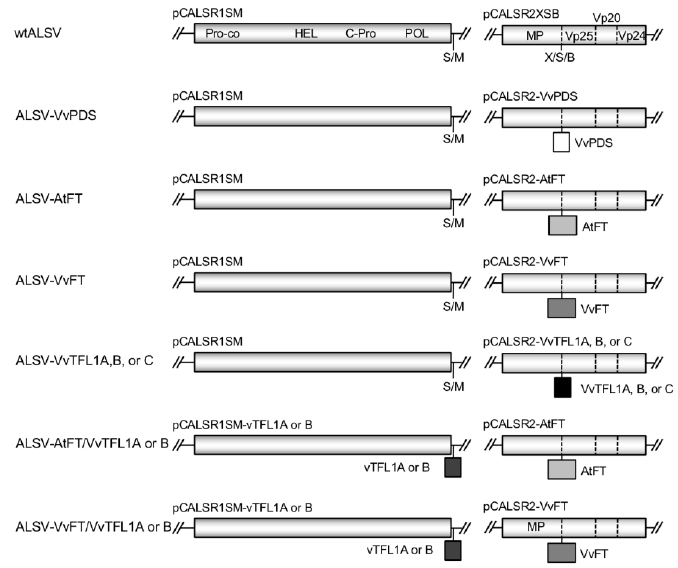
Figure 1. Schematic representation of infectious apple latent spherical virus (ALSV)-RNA clones (pCALSR1SM and pCALSR2XSB) and ALSV vectors containing a part of the phytoene desaturase (PDS) gene from grapevine (ALSV-VvPDS), full-length FT gene ( AtFT from A. thaliana or VvFT from grapevine), and part of the VvTFL A , B , or C gene from grapevine. S/M and X/S/B indicate cloning sites of Sal I/ Mlu I and Xho I/ Sam I/ Bam HI, respectively.